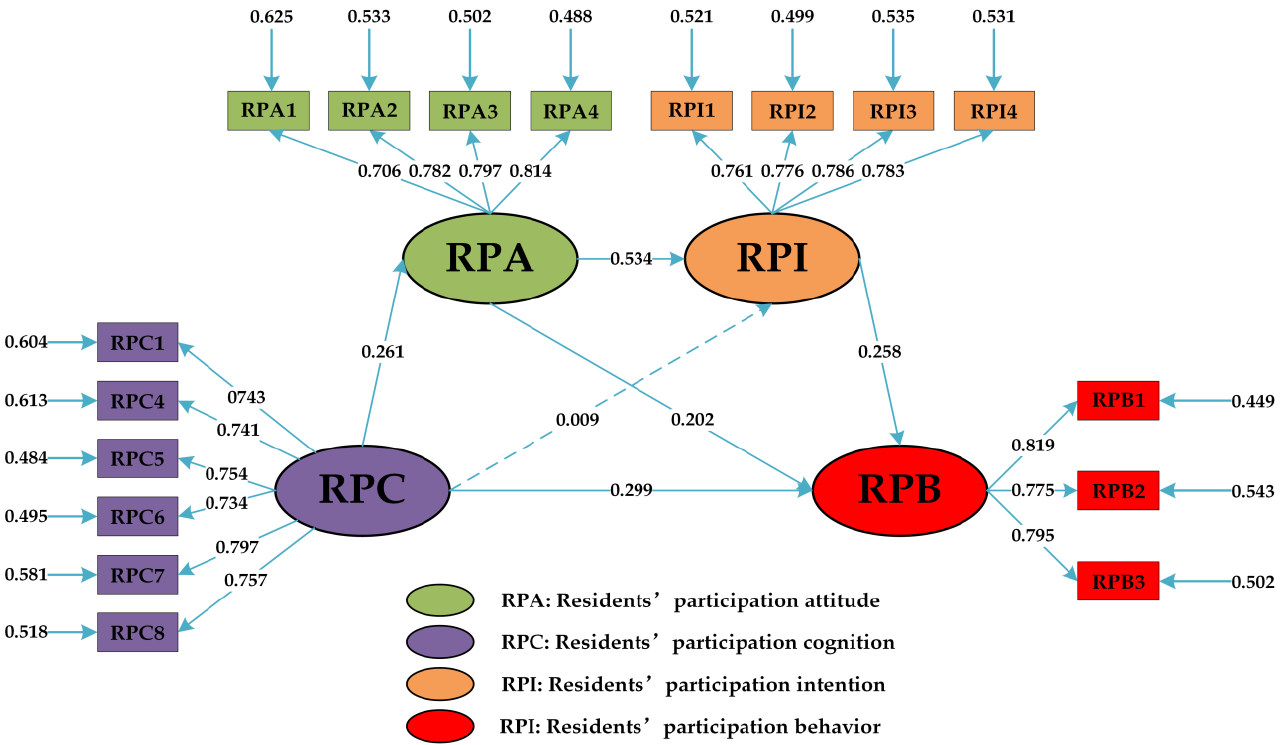
Figure 3. Structural equation model and result analysis diagram. Note: The RPC2 and the RPC3 were deleted to ensure that the scale has good convergent Table 3. Results of the hypotheses testing.